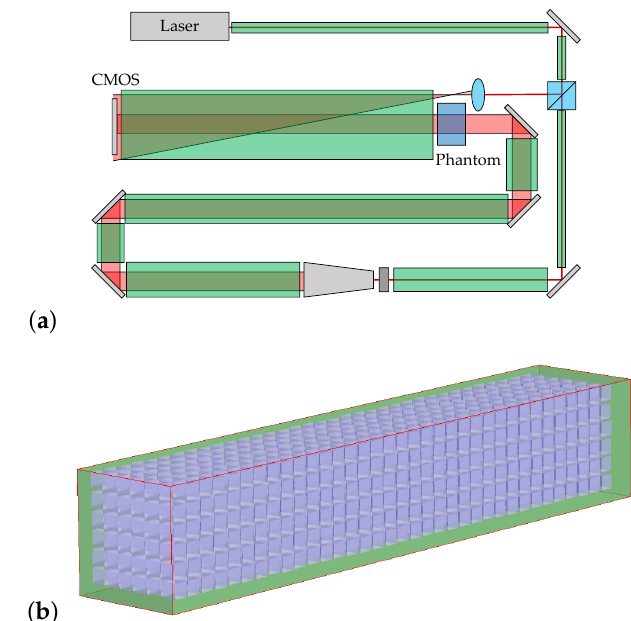
Figure 5. ( a ) Diagram showing the 9 bounding boxes (green) demarcating atmosphere within the dosimeter beamline. ( b ) Screenshot showing one of the boxes populated with atmospheric